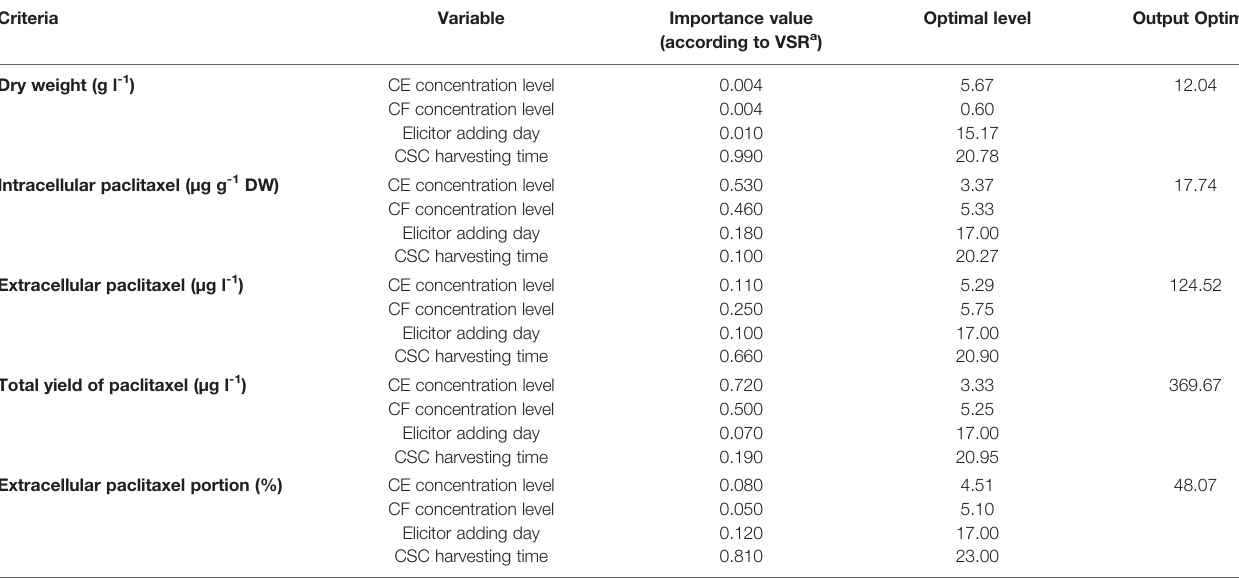
TABLE 3 | Importance (according to sensitivity analysis) and optimal levels of the di ff erent input variables including cell extract (CE), culture fi ltrate (CF) concentration levels (% (v/ v)), elicitor adding day and cell suspension culture (CSC) harvesting time (day) for achieving maximum growth, paclitaxel biosynthesis and secretion in Corylus avellana CSC using multilayer perceptron-genetics algorithm (MLP-GA) models.